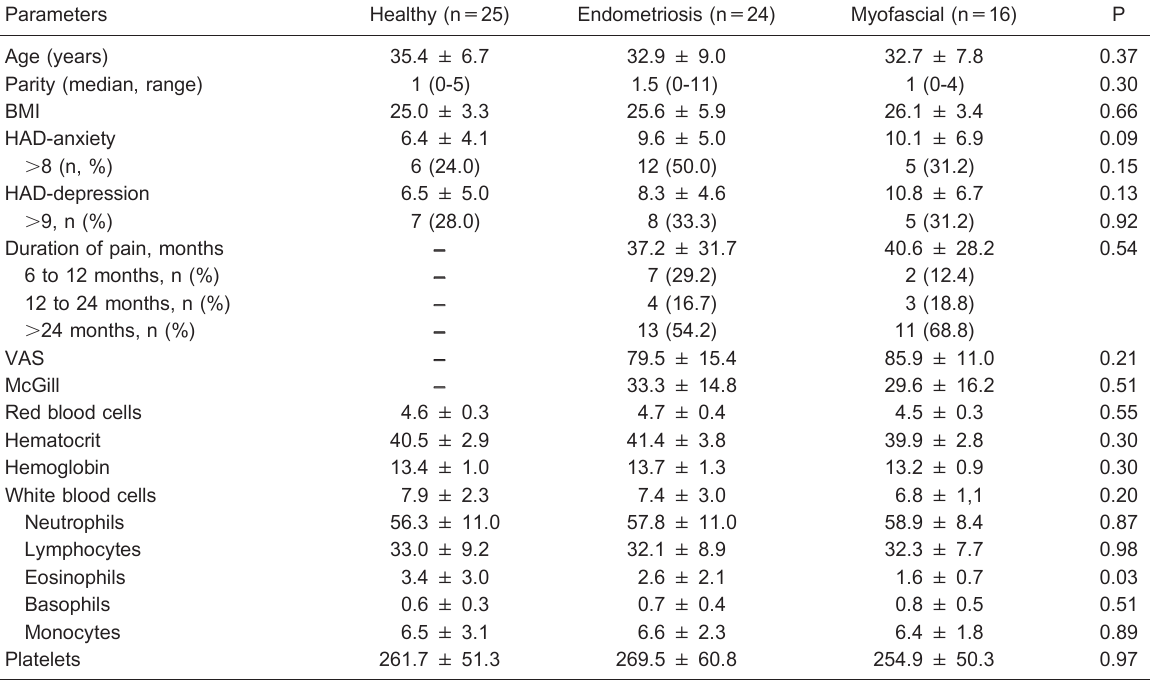
Table 1. Characteristics of the subjects included in the